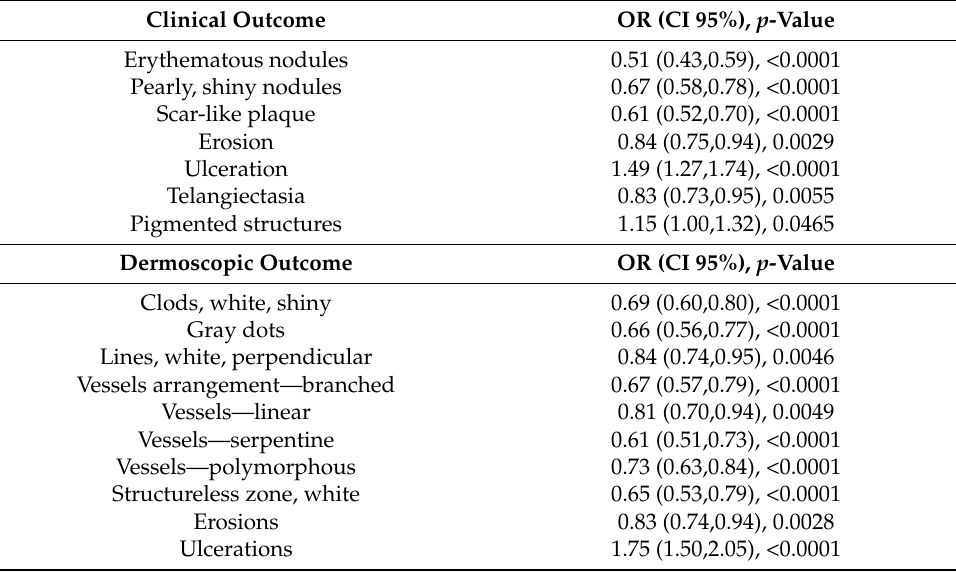
outcomes (univariate logistic regression with random effects).